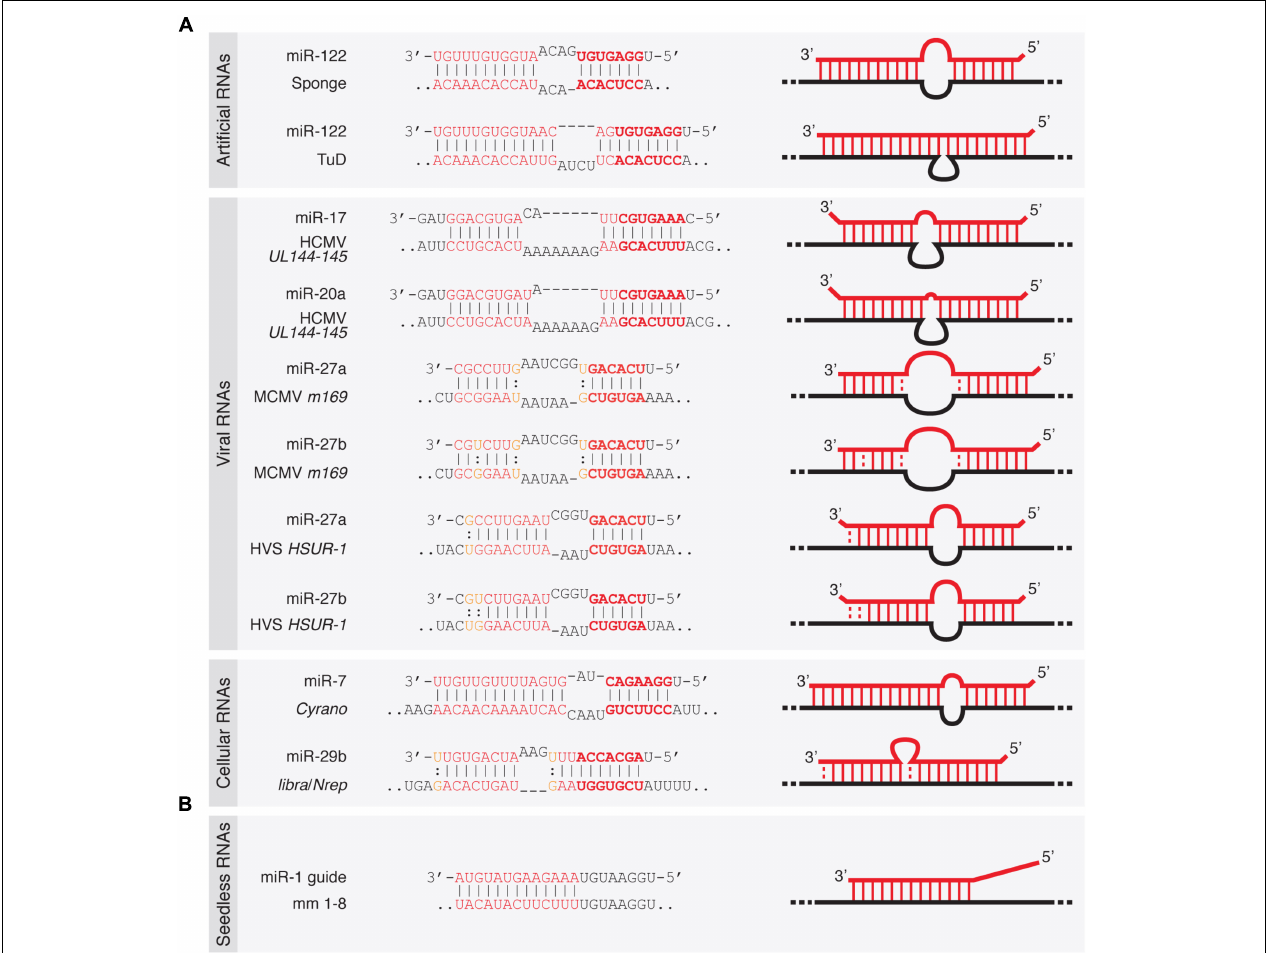
FIGURE 2 | Architecture of TDMD-inducing miRNA binding sites described in the literature. (A) Seed containing miRNA binding sites within artificially designed or naturally occurring target RNAs—either of viral or cellular origin. (B) Seedless miRNA binding site present in an artificial target RNA shown to elicit TDMD in vitro (Park et al., 2017). Dashes represent Watson–Crick base pairs and dots represent Wobble base